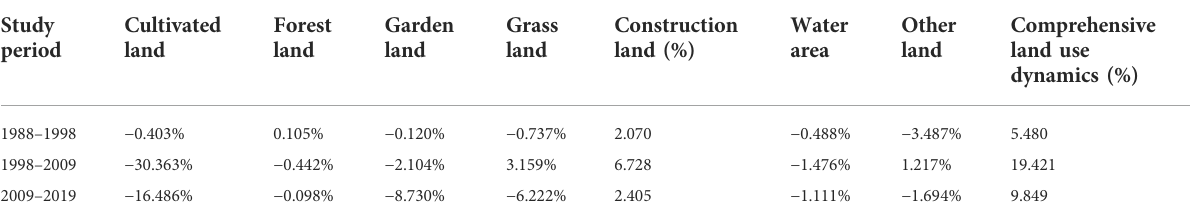
TABLE 4 Dynamic attitude of land use in Jinshitan (1988 –